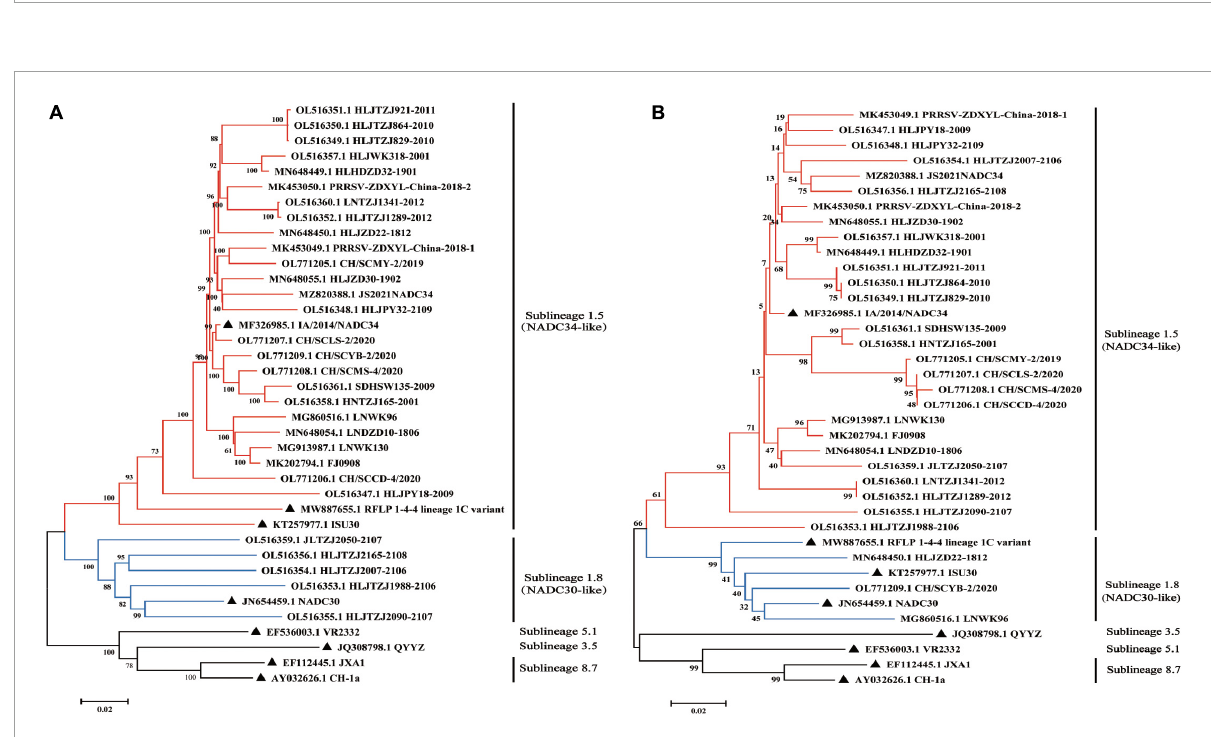
FIGURE2 Phylogenetic tree based on the whole-genome and ORF5-gene sequences of NADC34-like strains from China. (A) Phylogenetic analysis of NADC34-like strains in China and reference viruses based on whole-genome sequences. (B) Phylogenetic analysis of NADC34-like strains in China and reference viruses based on ORF5-gene sequences. Most of the NADC34-like strains isolated in China belonged to Sublineage 1.5, but a few recombinant strains fell into Sublineage 1.8. The phylogenetic tree was constructed using the distance-based neighbor-joining algorithm in Mega7 (Kumar et al., 2016), with 1,000 bootstrap replicates ( (cid:78) indicates the reference